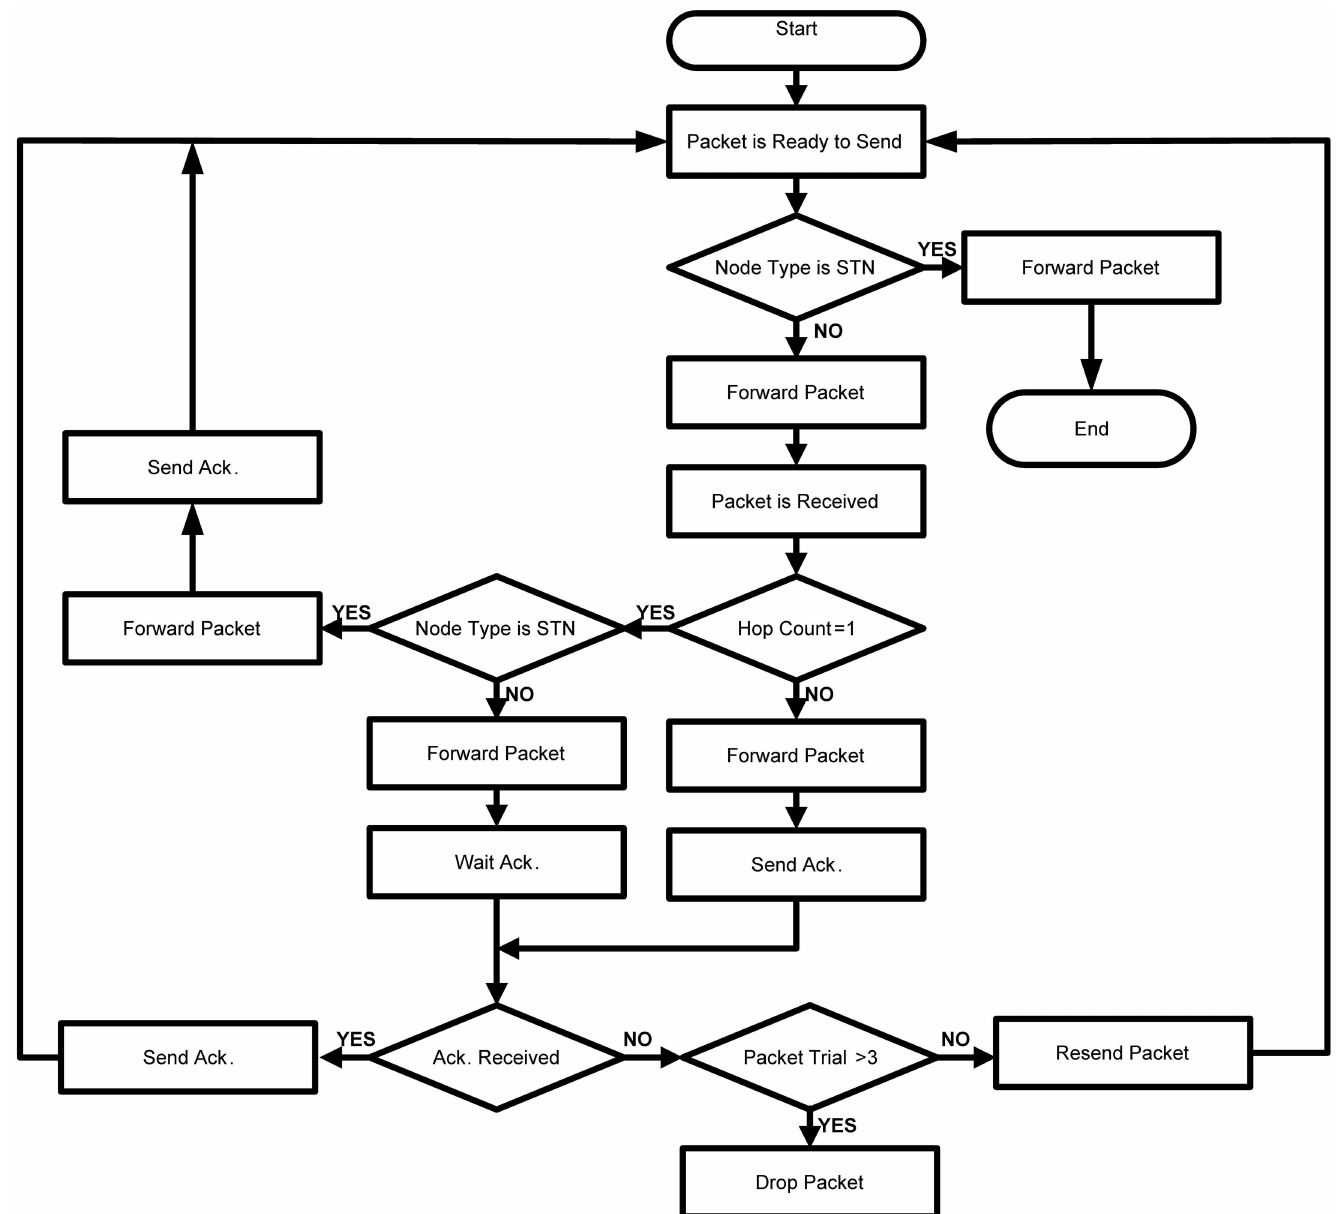
Fig 4. Data transmission phase in